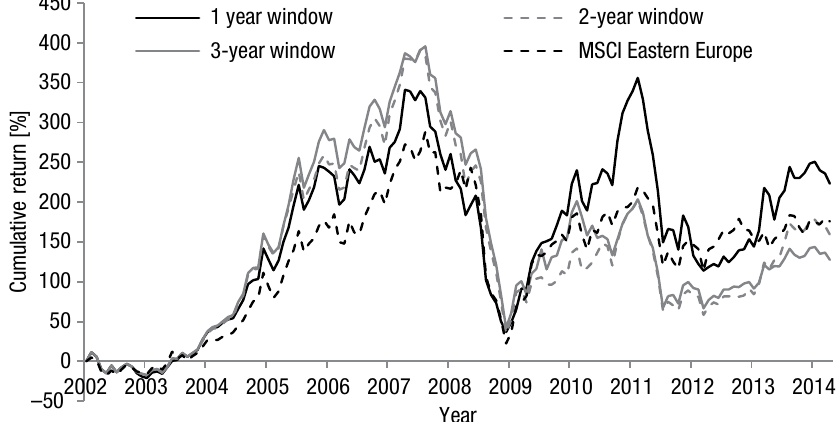
Fig. 4. Long-run cumulative returns on capitalization-weighted portfolios of acquiring